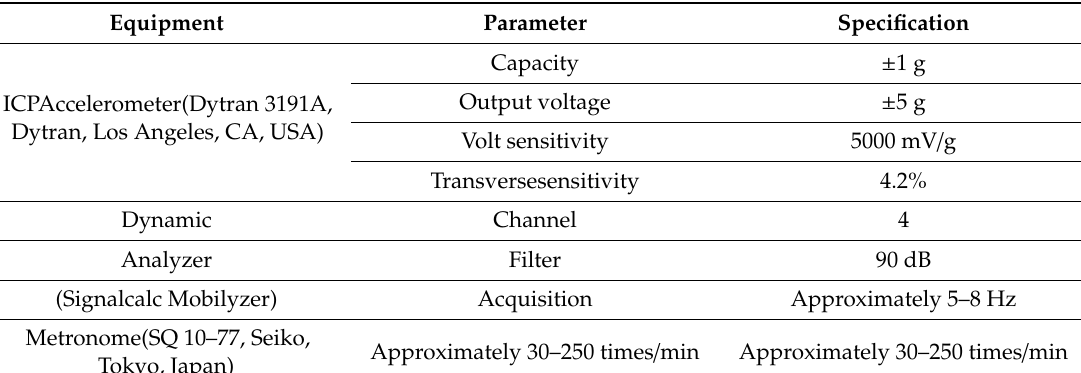
Table 2. Measurement